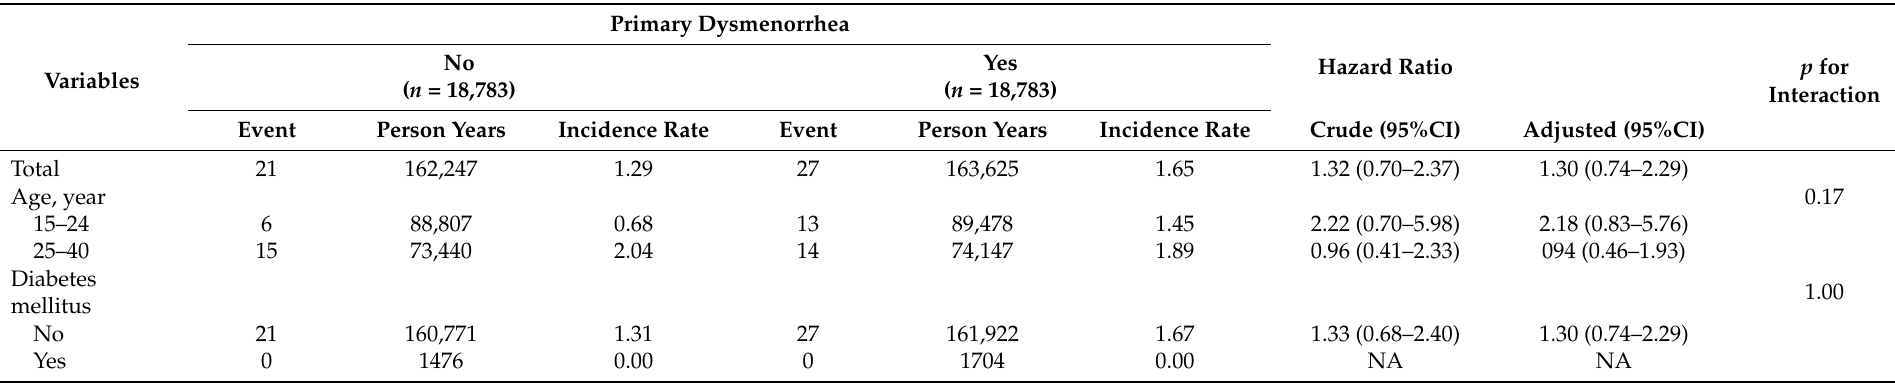
Table 4. Number of hemorrhagic stroke events and incidence rates in in primary dysmenorrhea and comparison cohorts by age, comorbidity, and NSAID use,